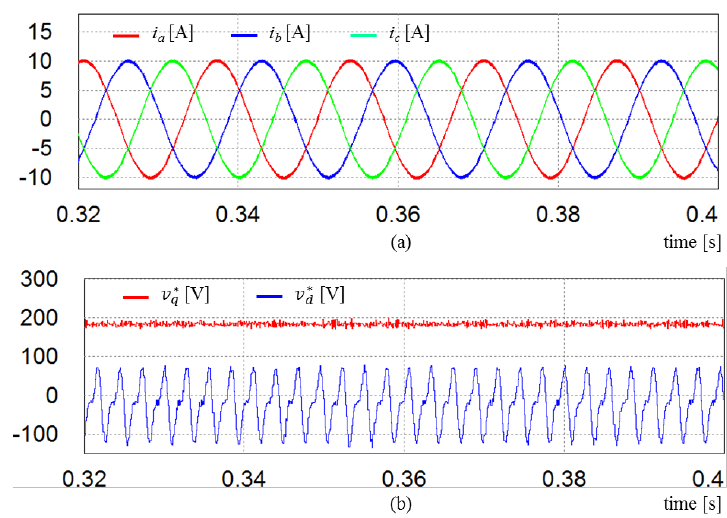
Figure 12. Control performance with harmonic compensation using the sliding mode control under distorted grid conditions: ( a ) inverter phase currents; and ( b ) inverter reference voltages.